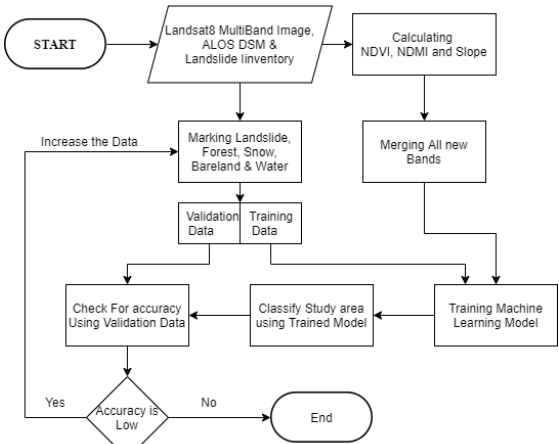
Figure 5. Proposed workflow of the methodology